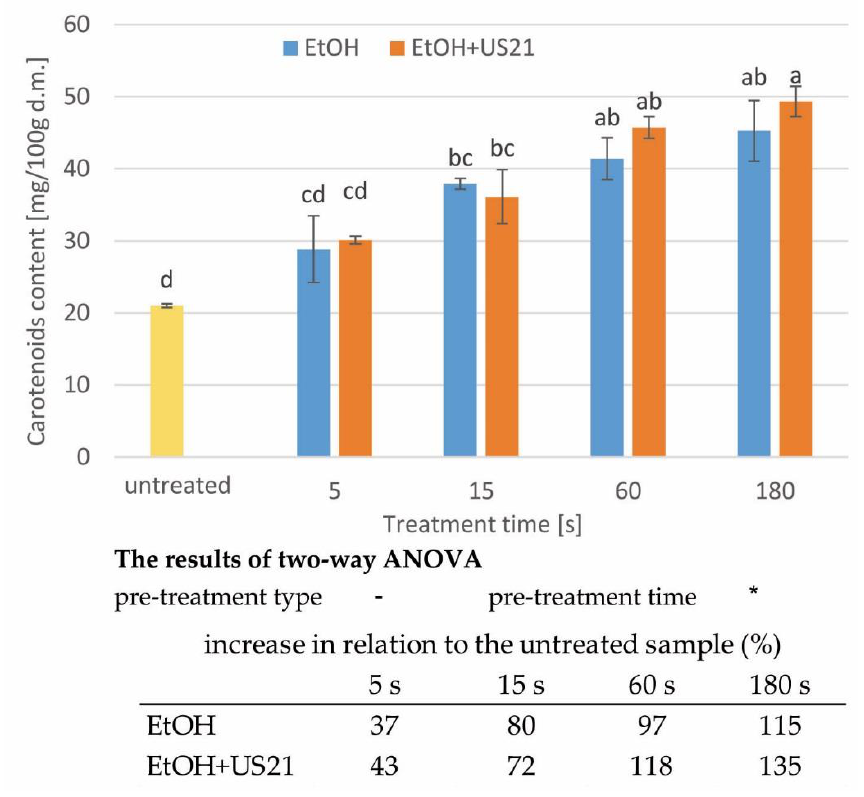
Figure 5. The carotenoid content in dried carrot tissue pre-treated in ethanol without (EtOH) and with ultrasound (EtOH+US21); a, b, etc.—different letters indicate different homogeneous groups (α = 0.05), the results of two-way ANOVA indicate the significance (*) or insignificance (-) of the influence of the type and time of treatment (α = 0.05). In table—the increase in carotenoid content in relation to the untreated dried sample.